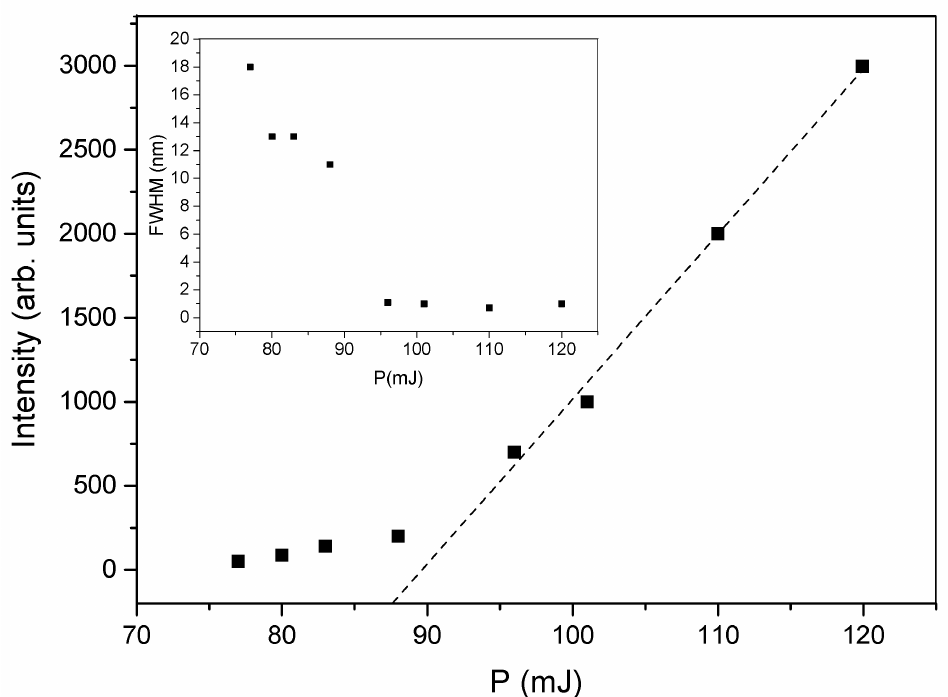
Figure 4. typical peak intensity as function of the pumping energy P. The inset shows the behavior of the full width at half maximum (FWHM) with increasing the pumping energy. The dashed line is a linear regression that helps the eye in finding the laser threshold.